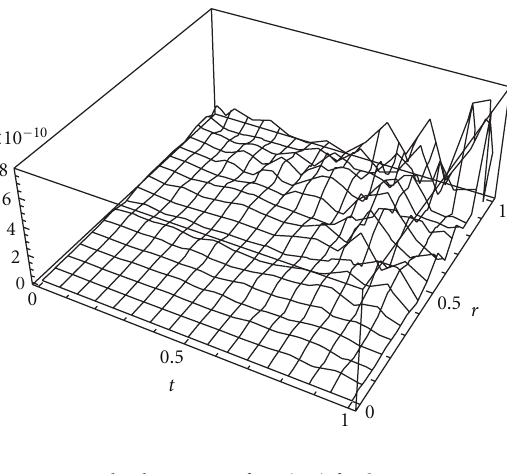
( t , r ) for (cid:2) = − 0 . 972969. 15